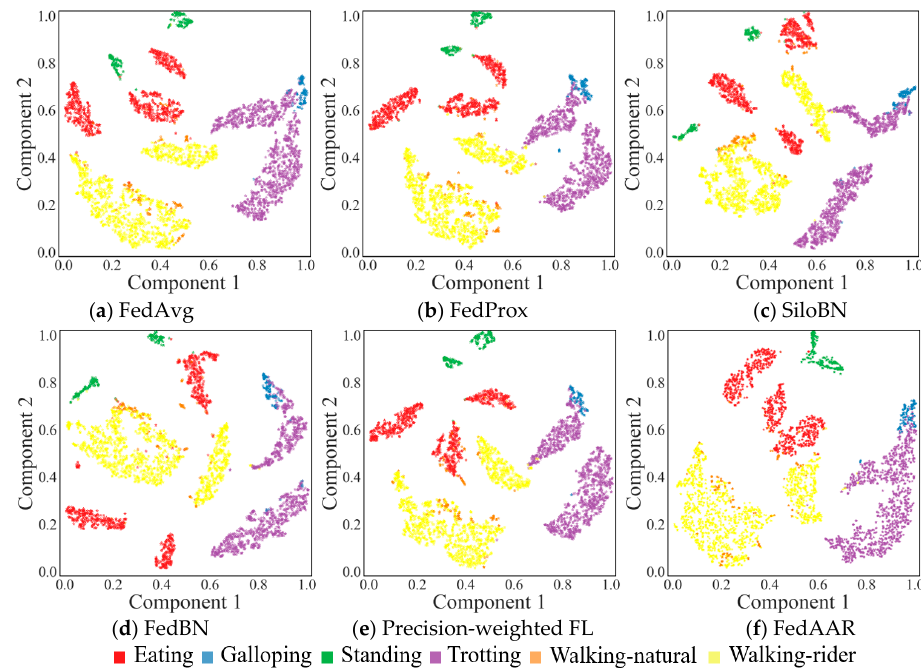
Figure 3. t-SNE visualisation of the feature vectors produced by our proposed FedAAR and other FL